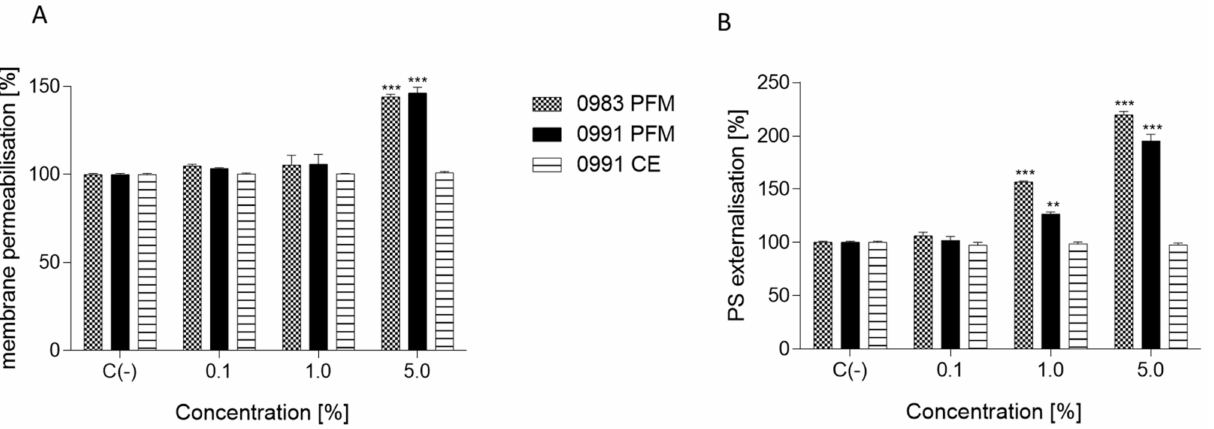
Figure 5. The influence of selected post-fermentation media (PFM) or cell extracts (CEs) on Caco-2 cell membrane permeabilisation detected with propidium iodide (PI) staining ( A ) and phosphatidylserine (PS) externalisation on the outer membrane leaflet of apoptotic cells and detected with Annexin-V- FITC Assay Kit ( B ) after 24 h incubation; values are means ± SD, n ≥ 4; statistical significance was calculated versus control cells (untreated), ** p ≤ 0.01, *** p ≤